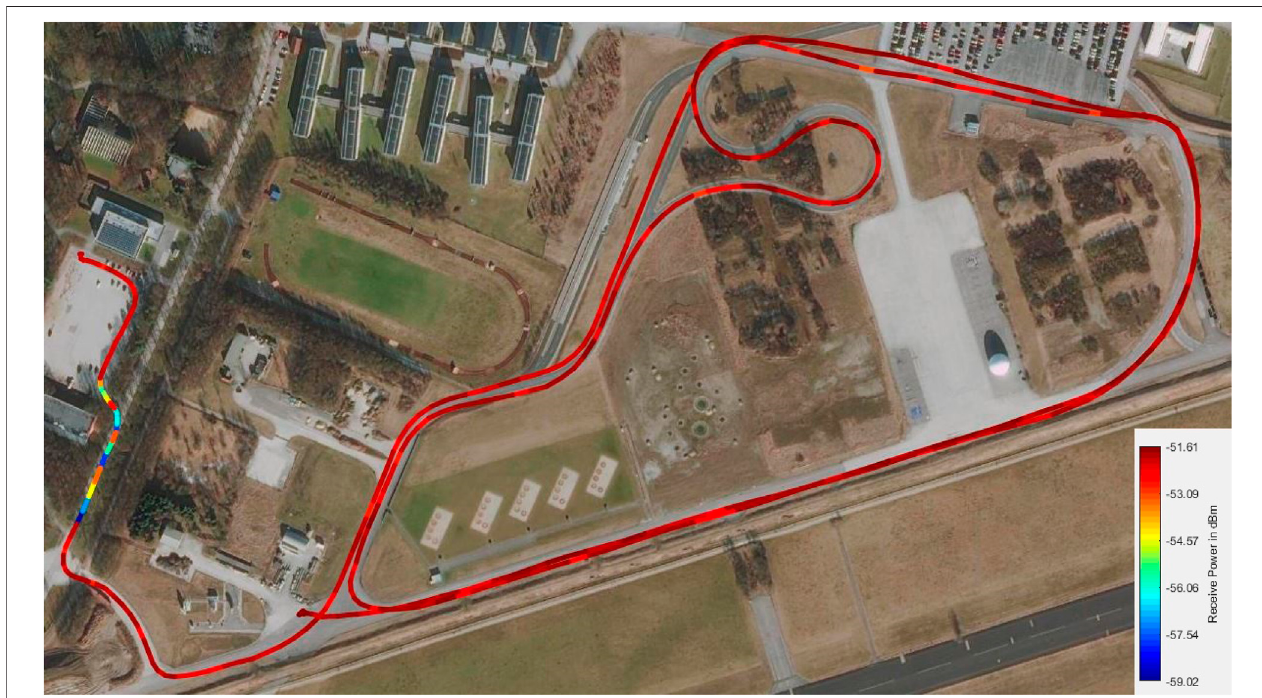
FIGURE 8 | Receive signal power in dBm at different locations of the test track.